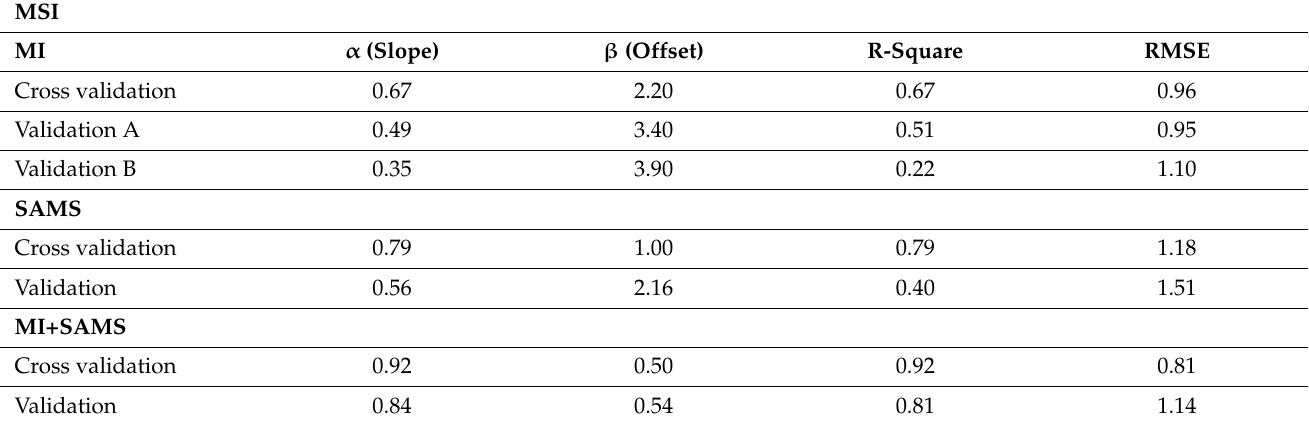
Table 6. Linear regression fit parameters between the actual and predicted TVC values for